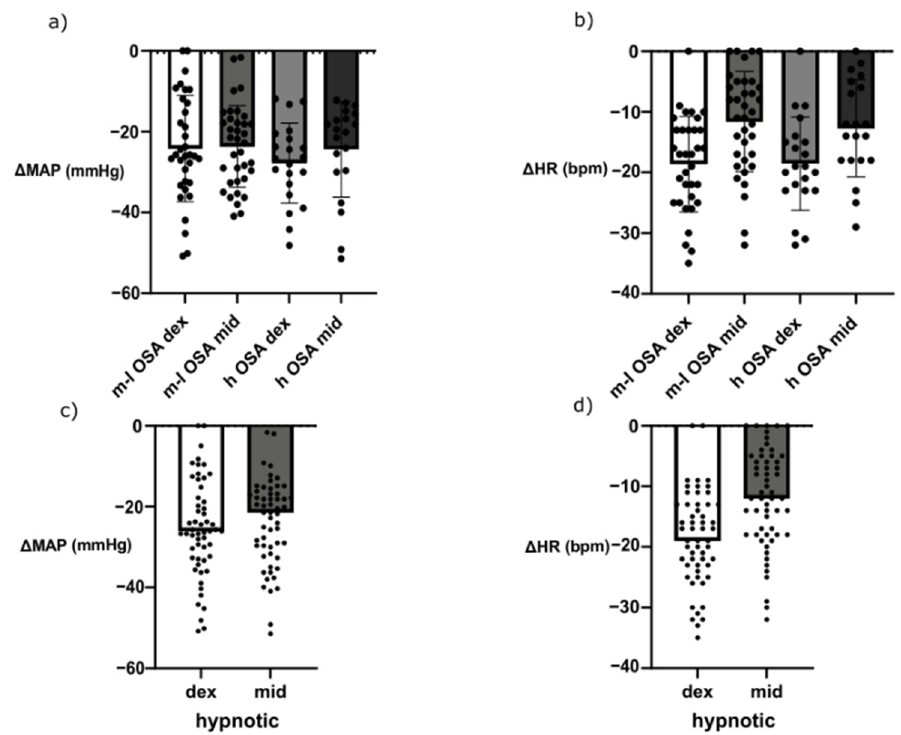
Figure 2. Hemodynamic outcomes. Maximal decrease from the baseline (i.e., pre-anesthesia measure- ment) of the mean arterial pressure (MAP) and heart rate (HR) in patients stratified by OSA risk and hypnotic; mean and SD are also presented ( a , b ). Maximal decrease from baseline of MAP and HR in patients stratified by hypnotic only; median is also presented ( c , d